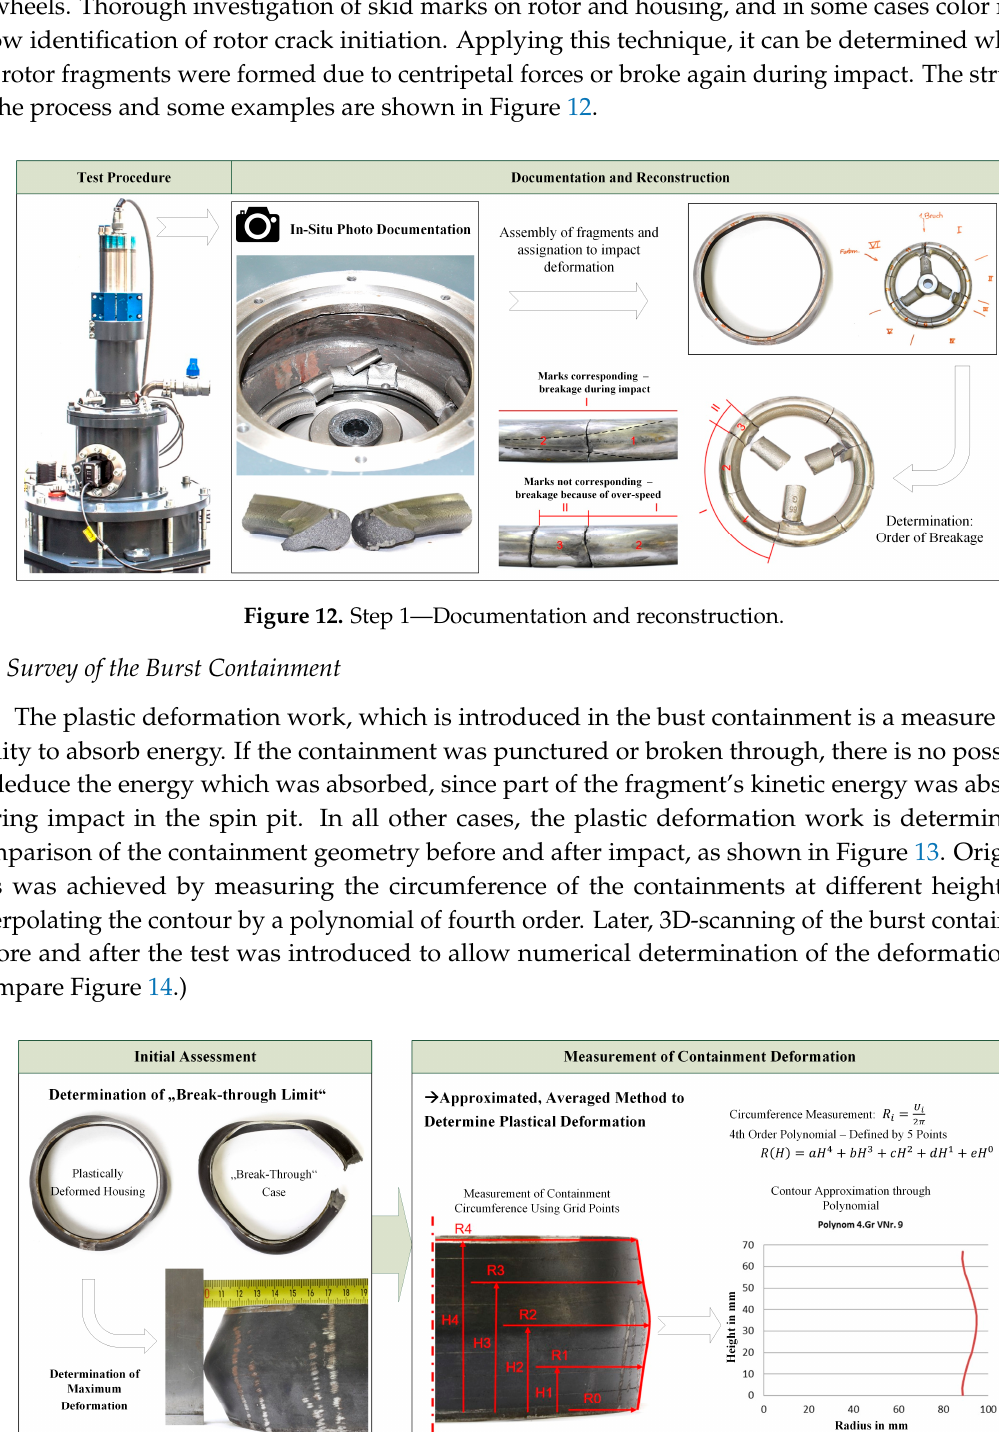
Figure 13. Step 2—Survey of containment deformation.